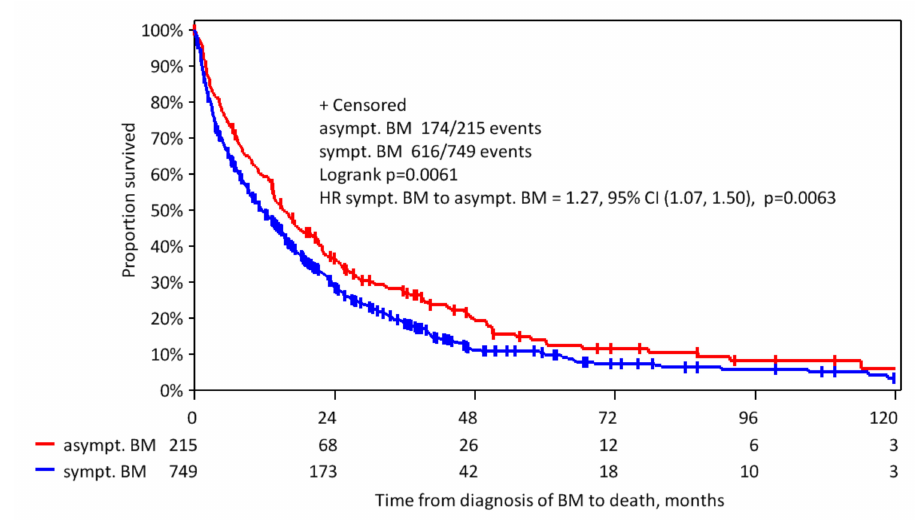
Figure 3. Kaplan-Meier curve for the time from first diagnosis of BM to death due to any reason among HER2-positive patients.